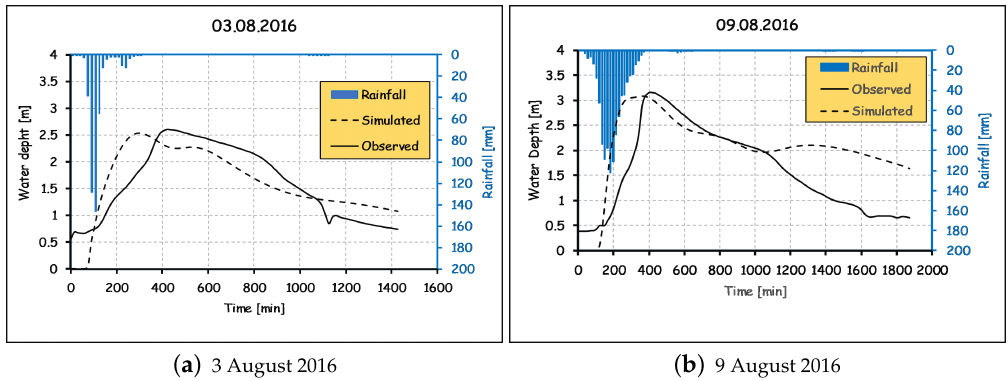
Figure 11. Water depth at the watershed